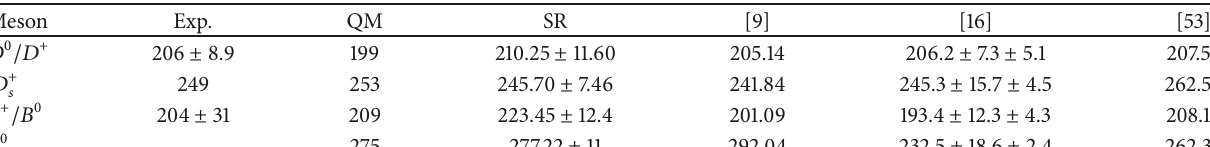
Table 2: Pseudoscalar and vector decay constants of heavy-light mesons in MeV. QM denotes quark model and SR denotes sum rule calculations.